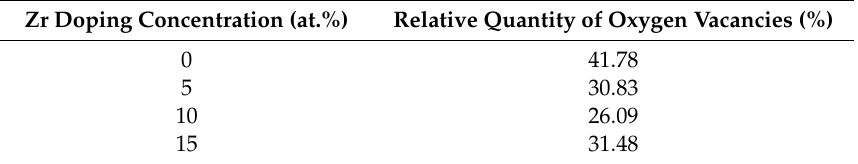
Table 2. The relative quantity of oxygen vacancies varied with the Zr doping concentrations. Zr Doping Concentration